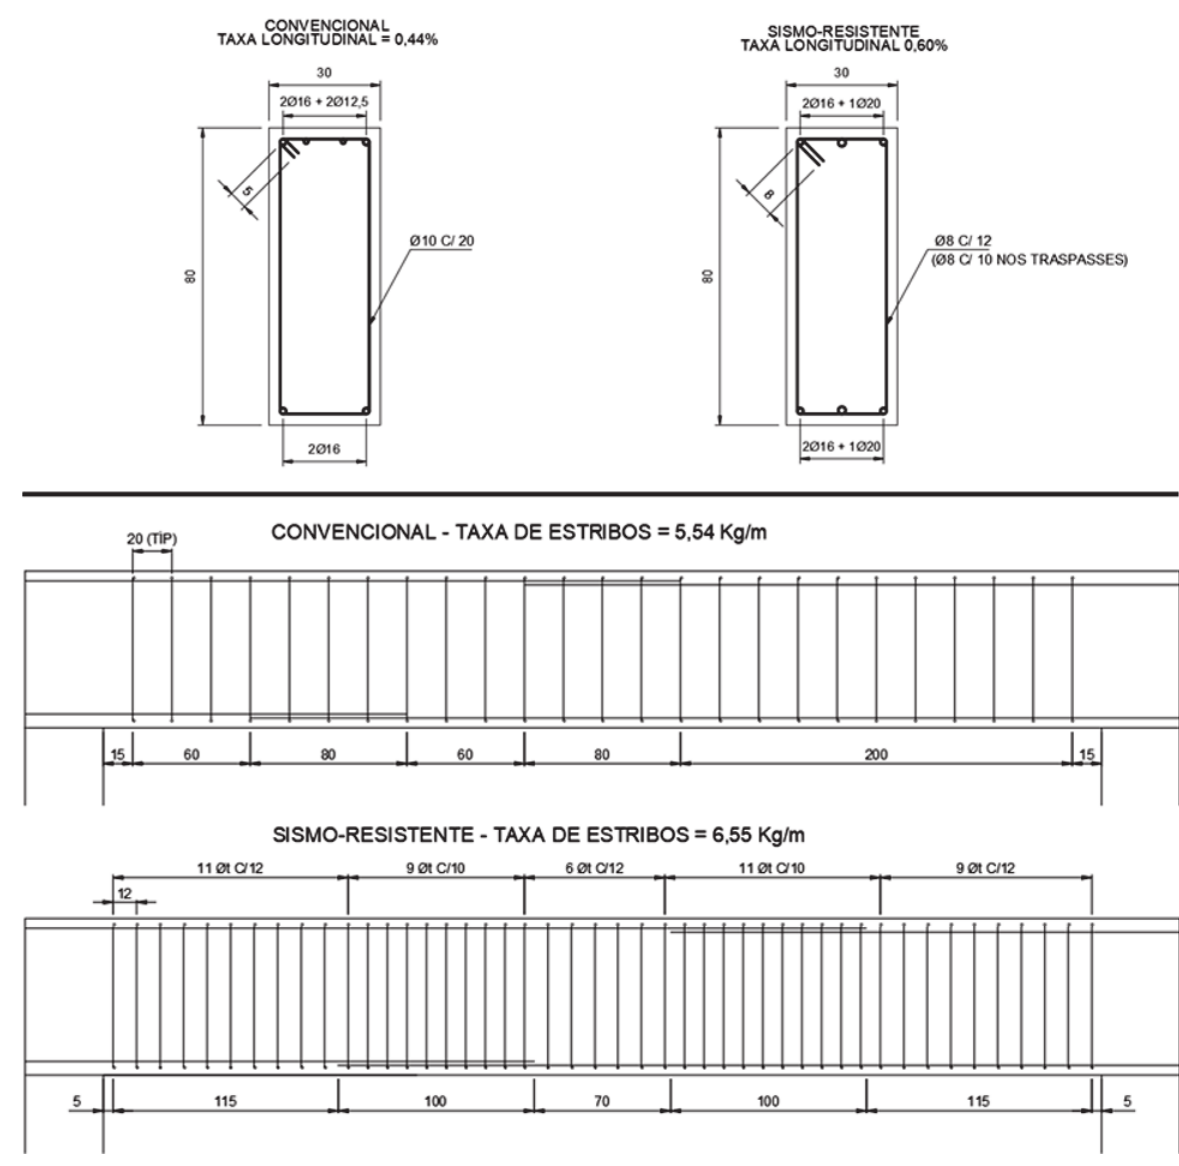
Comparativo de detalhamento convencional com detalhamento específico